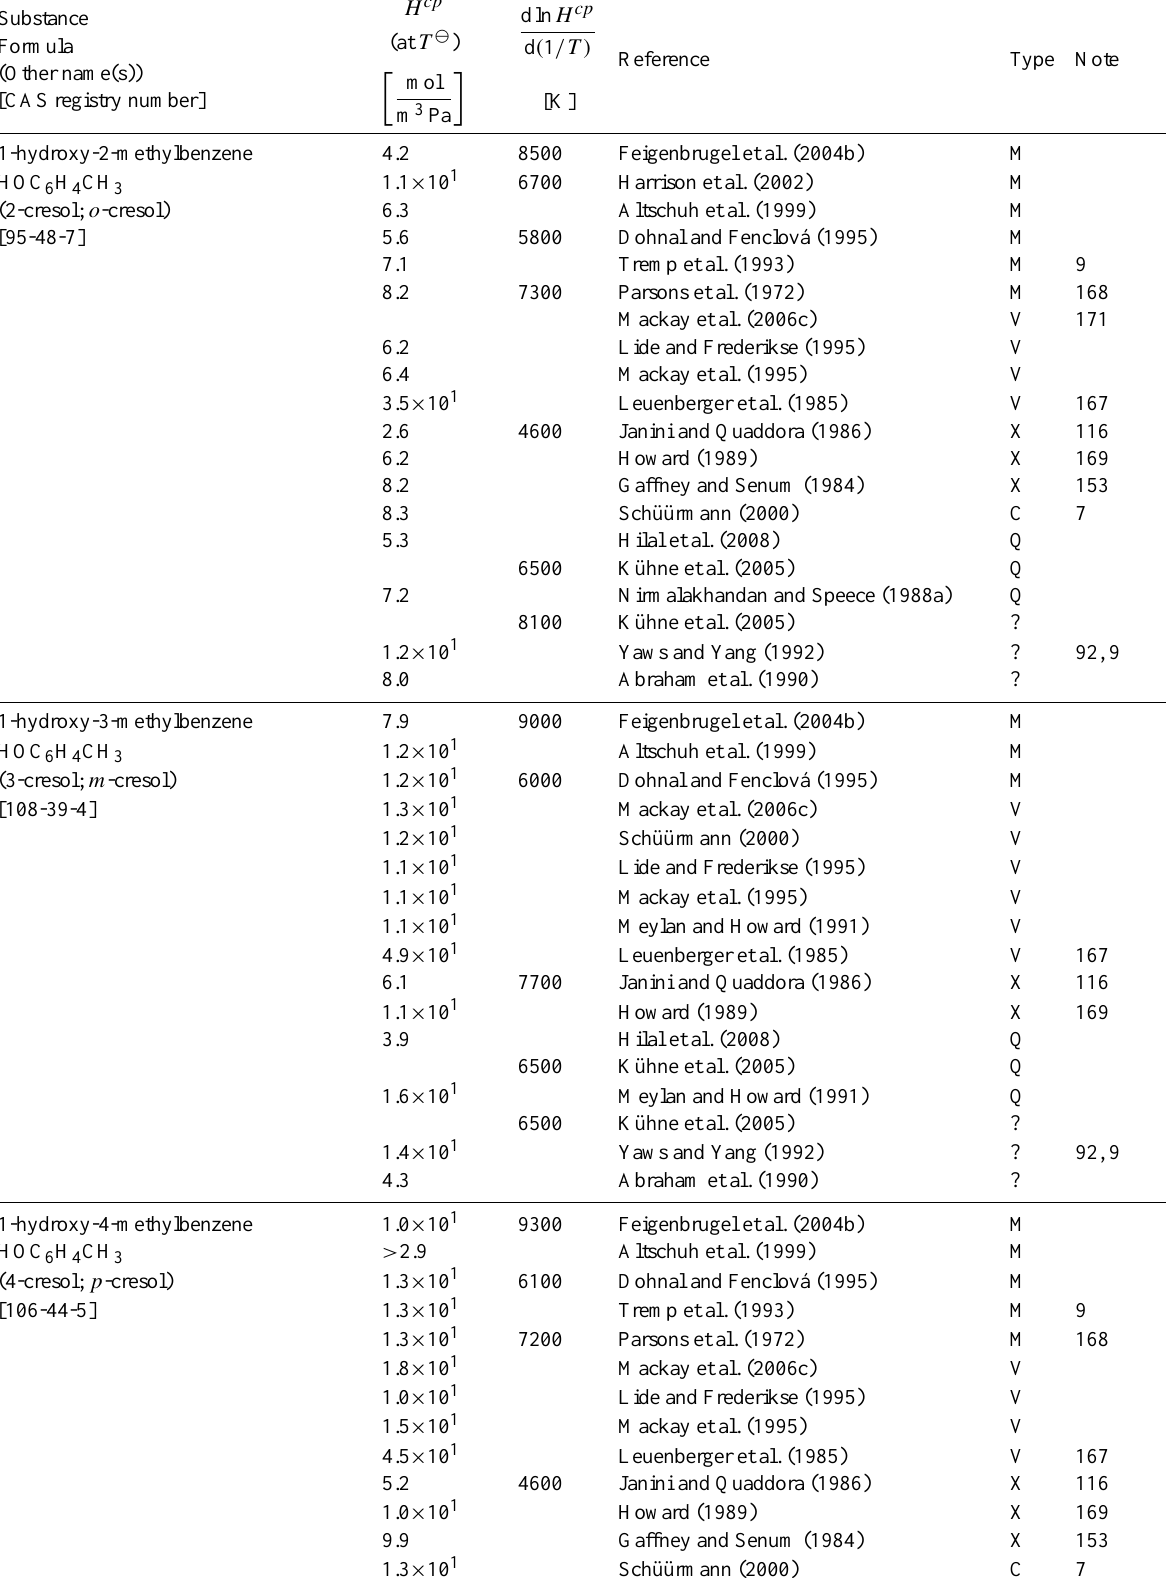
Table 6: Henry’s law constants for water as solvent